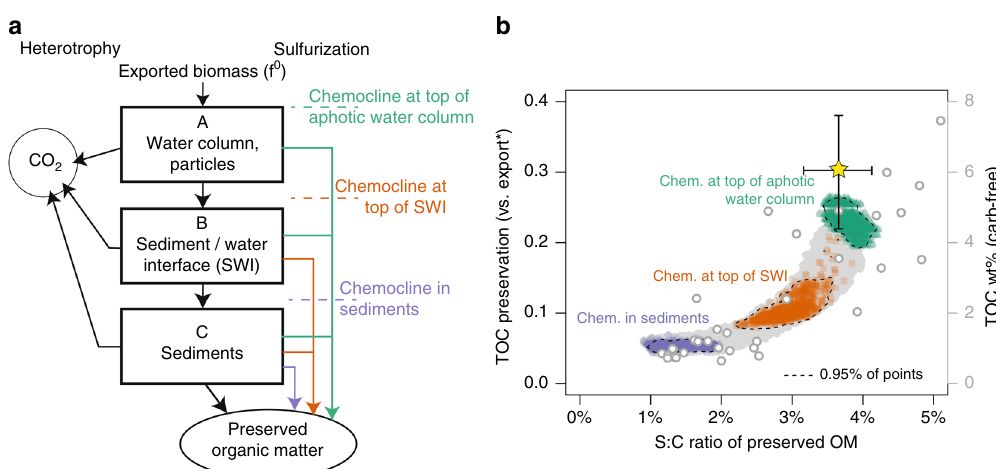
Fig. 4 Sedimentary organic carbon cycle model. a Organic carbon fl uxes in the model (see text). b Model results for the parameters in Table 1 and Supplementary Table 3 for sulfurization in all three boxes (chemocline at the top of the water column aphotic zone; green), boxes B and C (chemocline at the top of the sediment-water interface; orange), and c only (chemocline in the sediments; purple). Gray shading shows the effects of splitting boxes A or B into oxic and anoxic parts, representing a continuously moving chemocline. Cariaco parameters for box C export ( “ fi nal ” OM) and their fi tting tolerances are shown as the yellow star. Pont d ’ Issole data in TOC wt% (carbonate-free basis, Supplementary Table 1) are shown on the right-hand axis as open gray circles